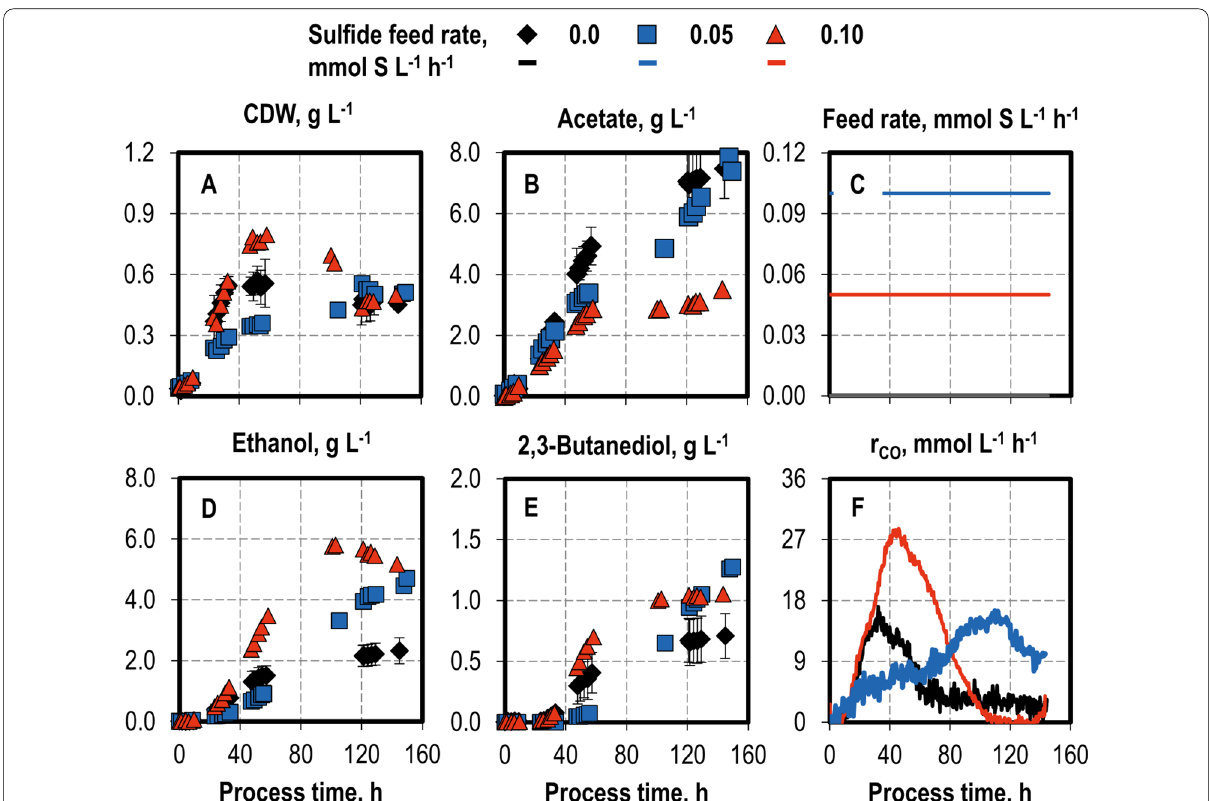
Fig. 4 Variation of sulfide feeding in autotrophic fed‑batch processes with C. ragsdalei in a continuously gassed STR. Cell dry weight ( A CDW) and product concentrations ( B acetate; D ethanol; E 2,3‑butanediol) and CO uptake rates ( F r CO ): no feed ( C black diamonds, black lines), 0.1 mmol S L − 1 h − 1 ( C blue squares, blue lines) and 0.05 mmol S L − 1 h − 1 ( C red triangles, red lines). The fed‑batch processes were operated at a temperature of 37 °C, working volume of 1 L, volumetric power input of 3.5 W L − 1 , pH 6.0, and a gas flow rate of 5 NL h − 1 with an inlet partial pressure of 0.2 bar H 2 , 0.2 bar CO 2 , and 0.6 bar CO. Standard deviations are shown for the processes at pH 6.0, which were conducted in triplicate; CO uptake rates are shown without standard